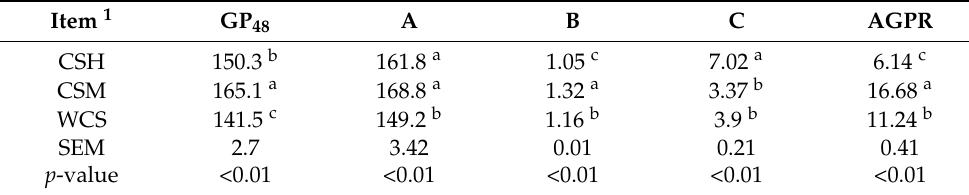
Table 3. Gas production kinetic parameters of cottonseed and its by-products.